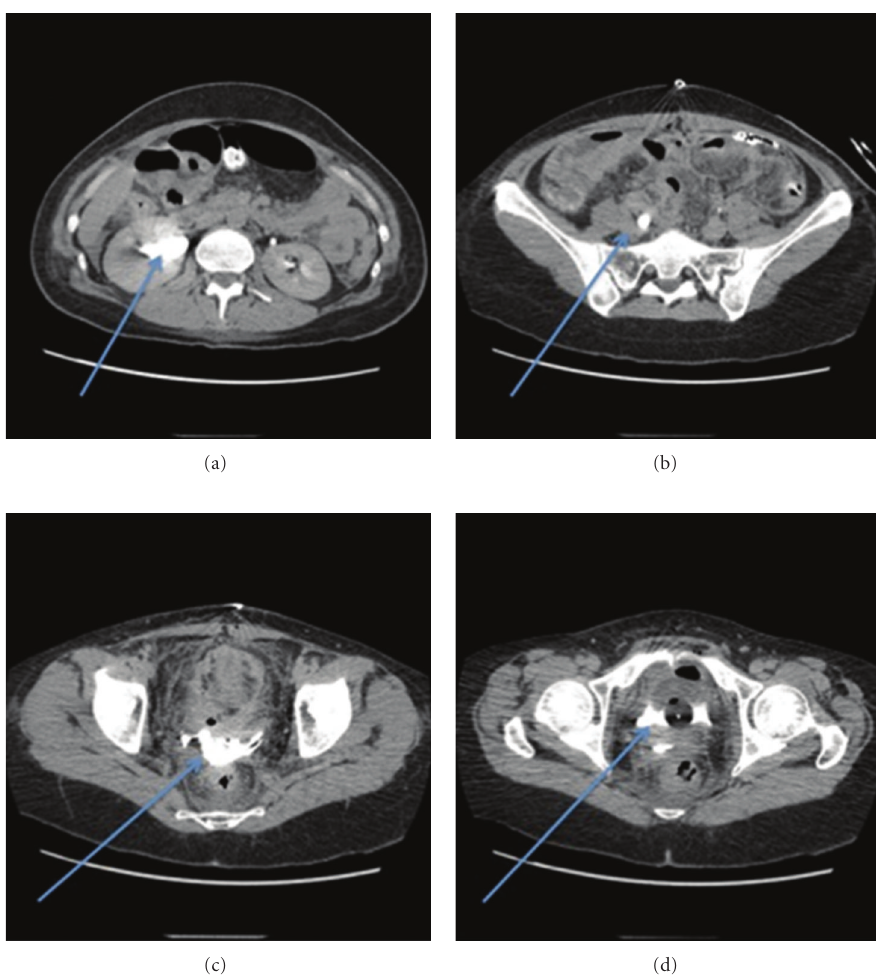
Figure 2: CT scan of the abdomen and pelvis on postoperative day 17. (a) Excretory phase. The arrow shows dilatation of the right pyelocaliceal cavities. (b) Dilatation of the right ureter. (c) and (d) Urinoma with extravasation of contrast agent into the pelvis.